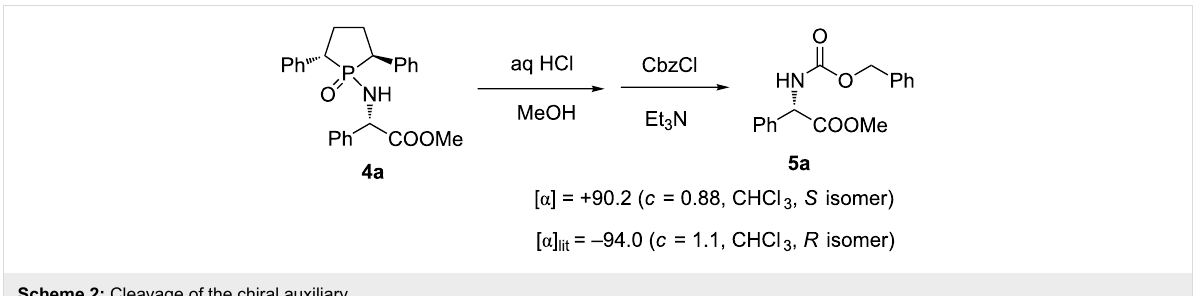
Scheme 2: Cleavage of the chiral